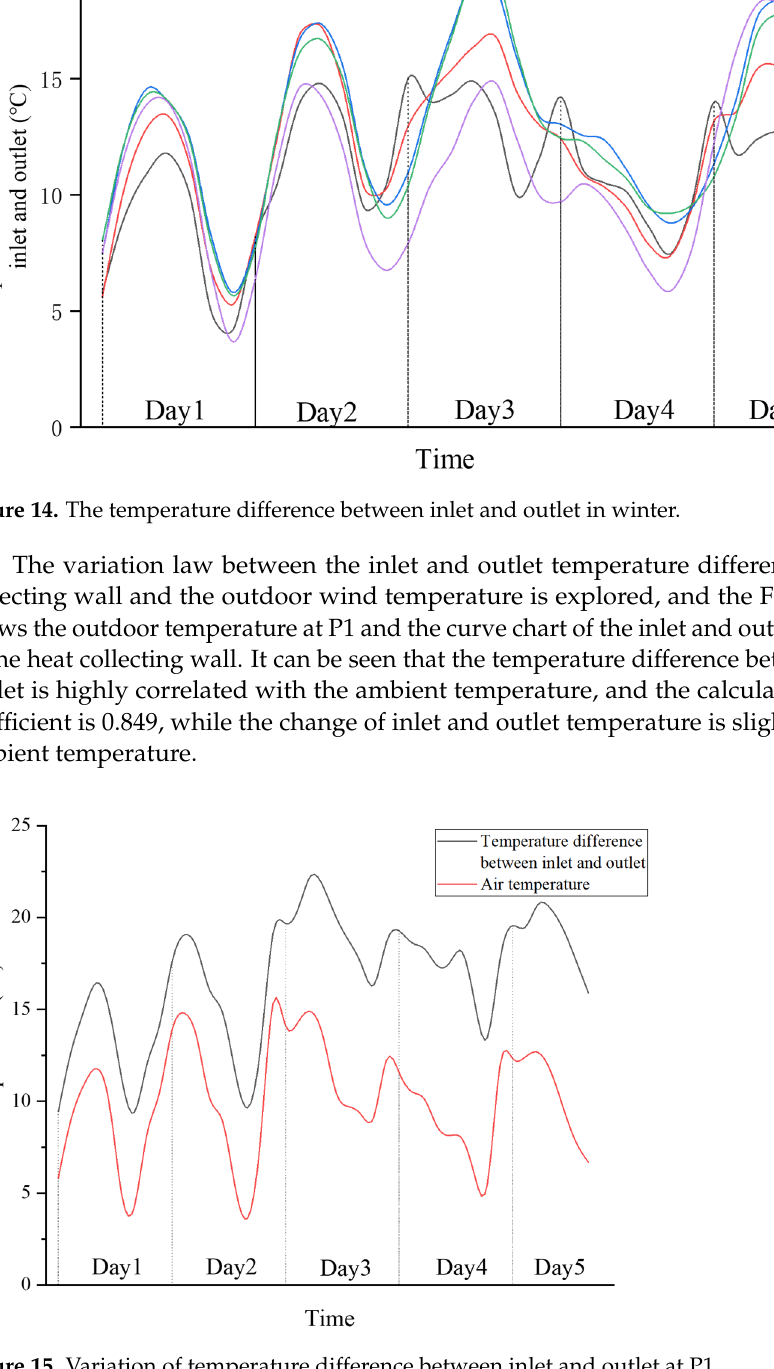
Figure 16. Change of airflow velocity and outdoor temperature at P1. 5.1.3. Heat Collecting Efficiency The heat supplied to the room by the heat collection wall outlet is calculated as follows: (cid:1843) (cid:3040) = (cid:1865)(cid:1855) (cid:3043) ((cid:1872) (cid:3042) − (cid:1872) (cid:3036) )